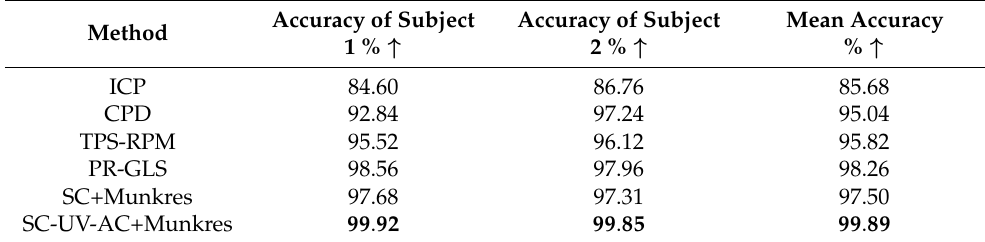
Table 2. Quantitative comparison of accuracy with existing